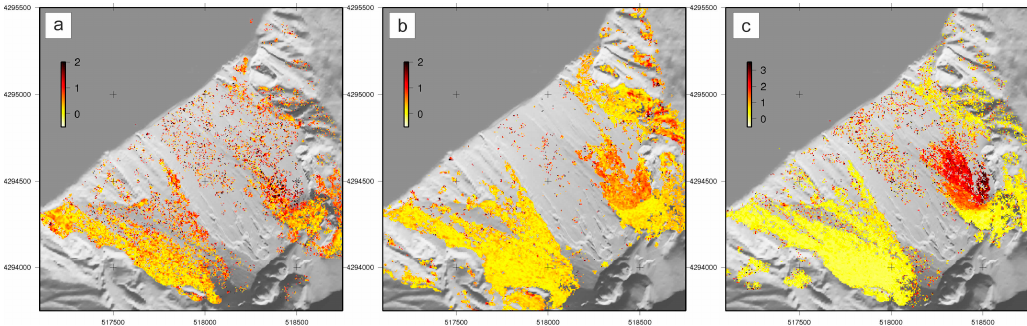
Figure 2. Magnitude (2D modulus) of the horizontal deformation (in meters). ( a ) September 2003–August 2004; ( b ) August 2004–May 2005; and ( c ) September 2003–May 2005. A-A' and B-B' dashed lines indicate the track of the profiles shown in Figure 3.